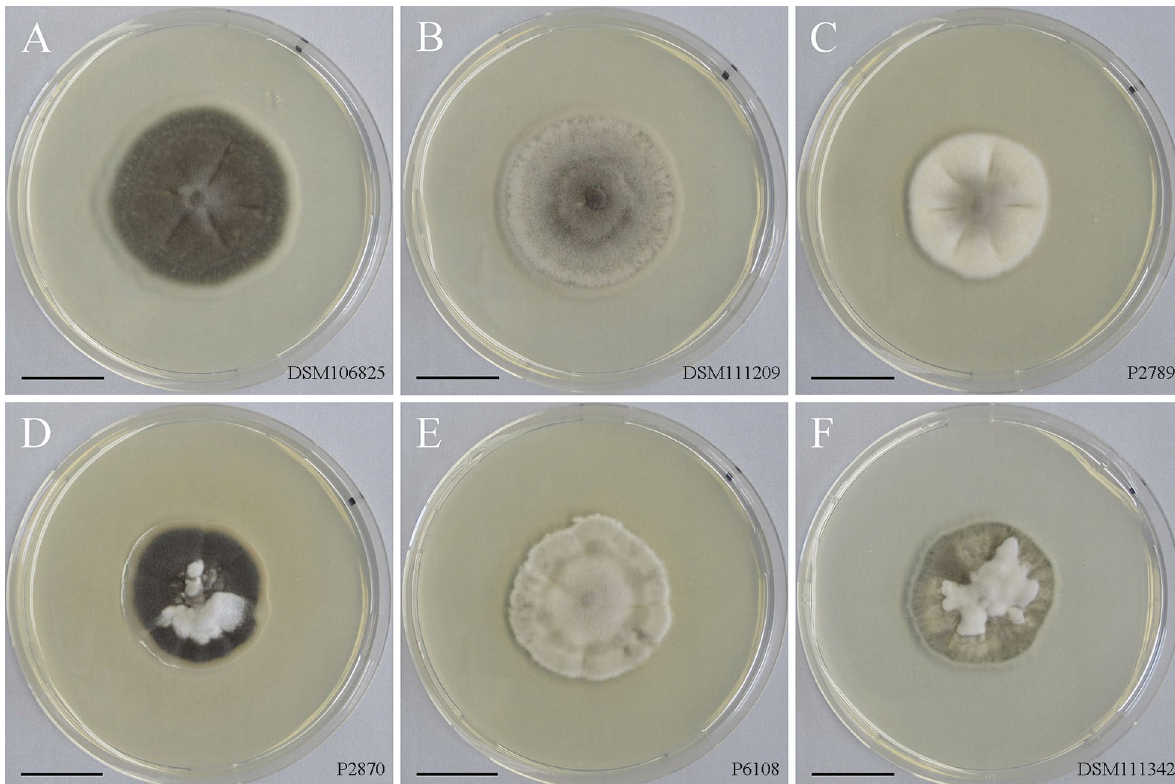
Fig. 1 Colony morphology of the studied isolates grown on potato dextrose agar for 1 month. Strains number are given as inserts in the pictures. a , b strains DSM106825 ( a ) and DSM111209 ( b ) isolated from eggs of Heterodera filipjevi . c – f strains isolated from roots of Microthlaspi perfoliatum ; strains P2789, 2870 and P6108 sampled from Germany, and strain DSM 111342 sampled from Bulgaria. Bars